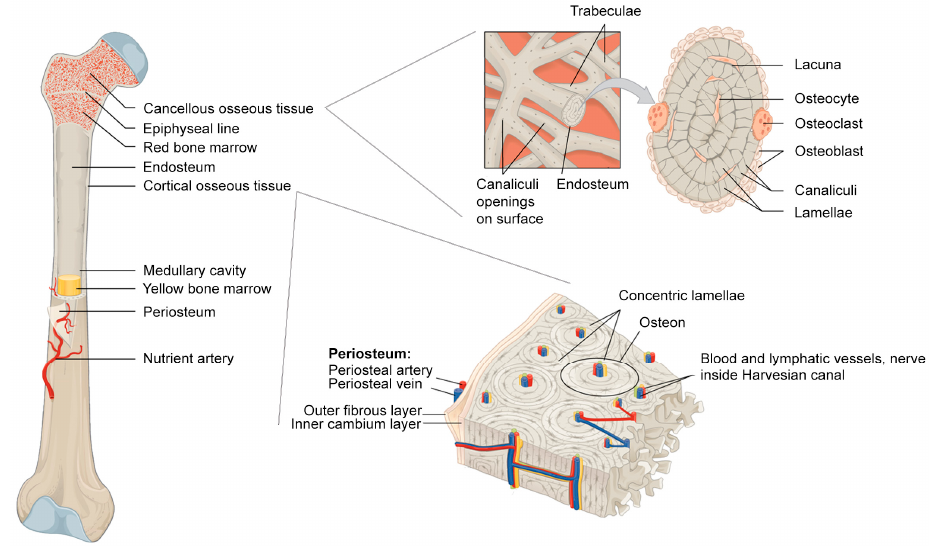
Figure 1. Bone anatomy. Modified and combined from Wikimedia Commons by OpenStar College CC BY 3.0 license [11].